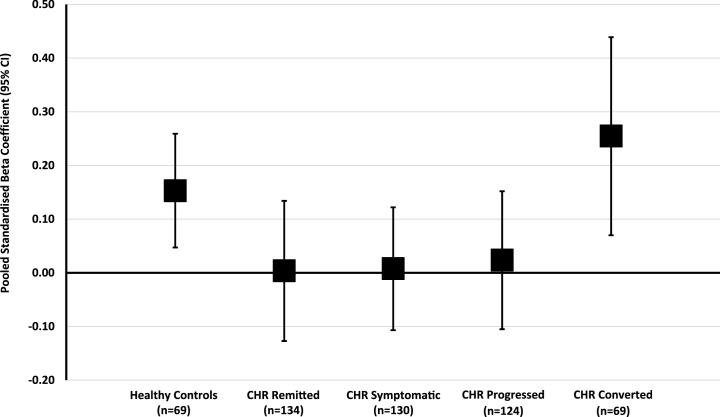
Pooled standardised beta coefficients (with 95% confidence intervals), representing the magnit ude of stressor-cortisol concordance, by group status at follow-up.